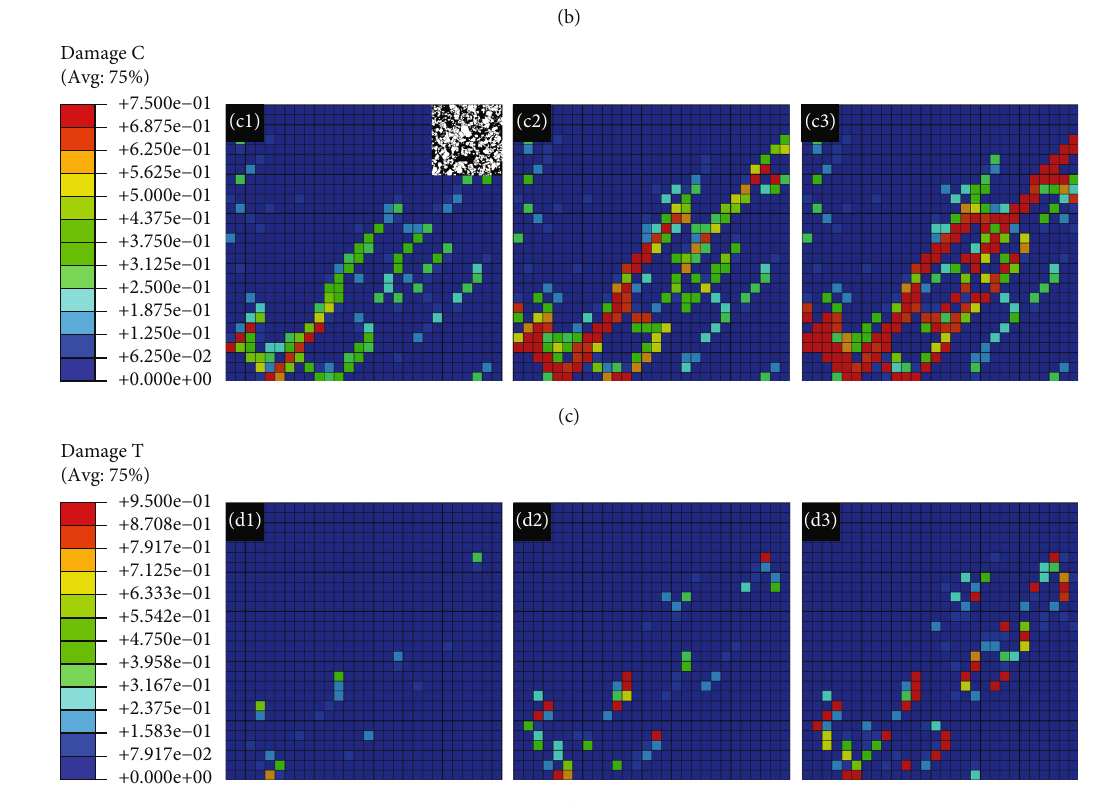
Figure 5: Compressive and tensile damage evolution under two loading directions: (a) compressive and (b) tensile damages under loading in the y -axis direction and (c) compressive and (d) tensile damages under the loading in the x -axis direction. For each row, the subimages with labels 1-3 represent the damage cloud charts at points A (peak strain), B (softening stage), and C (residual stage) in Figure